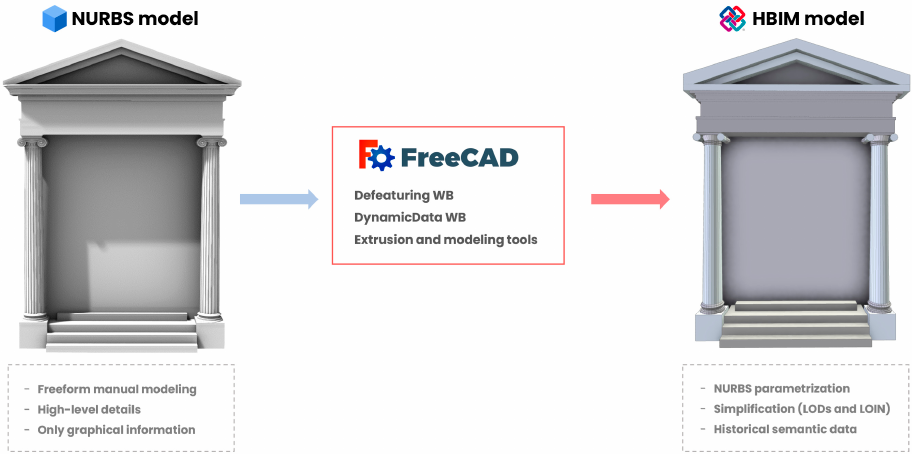
Figure 7. From NURBS to HBIM model via FreeCAD open source software: default tools and implemented workbenches for converting NURBS into parametric and informative